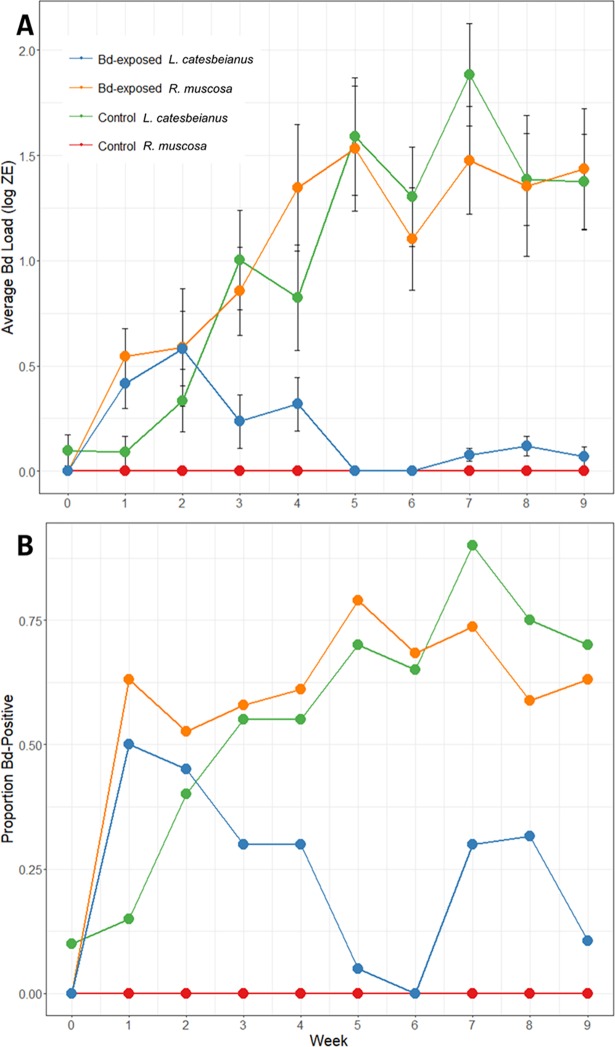
Bd prevalence and intensity across all treatment groups throughout the experiment.(A) Average Bd load, measured as log Bd zoospore equivalents (ZE) from qPCR of skin swabs, for each treatment group over the duration of the experiment. Error bars are standard error of the mean. (B) Proportion of individuals in each treatment group that were positive for Bd (ZE > 0.01) every week for the duration of the experiment.